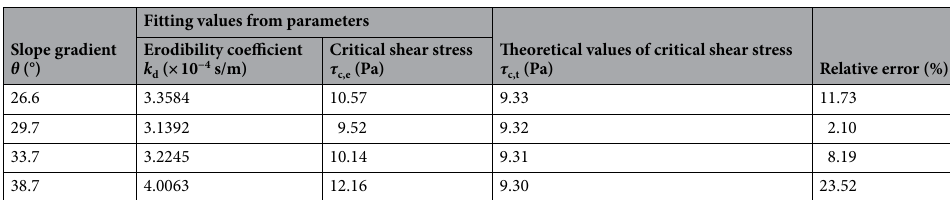
Table 3. Coefficient conclusion of the fitting lines and comparison between the fitted and theoretical critical shear stress